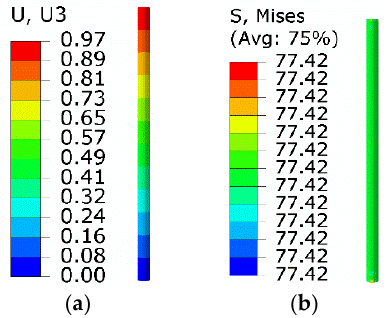
Figure 8. Results of step 4: ( a ) axial displacement; ( b ) equivalent stress.